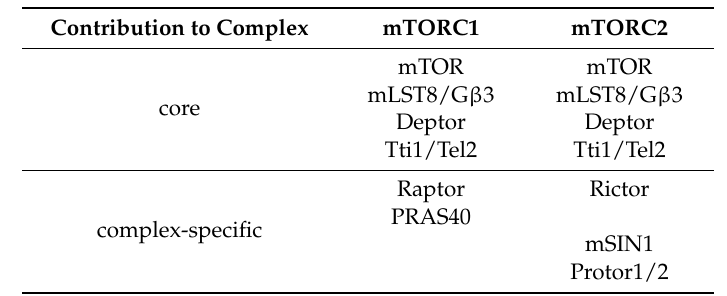
Table 1. mTOR complex subunits.